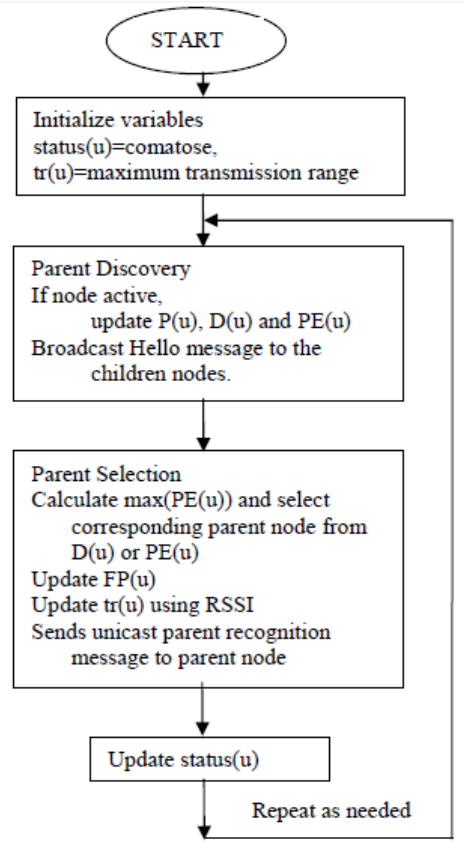
Fig. 5. SWST topology control